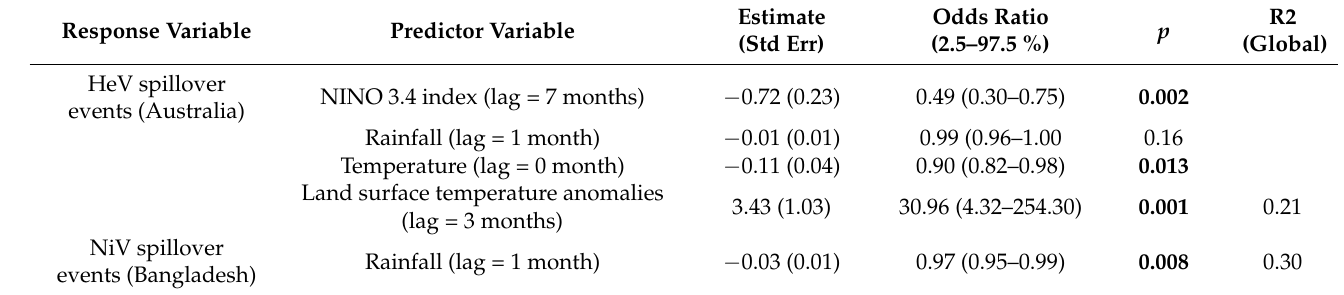
Table 5. Results of the logistic regression modelling with lags to explore the temporal association be- tween spillover events of the Hendra virus (HeV) and the Nipah virus (NiV) from January 1993 to June 2020. The initial models included the following variables: the NINO 3.4 index, the average monthly temperature in Australia/Bangladesh, the average monthly rainfall in Australia/Bangladesh, and the land surface temperature anomalies with lag values obtained from time-series cross-correlation analysis (Table 4). The best explanatory models were selected using a backward procedure with AIC criterion. Significant p -values are highlighted in